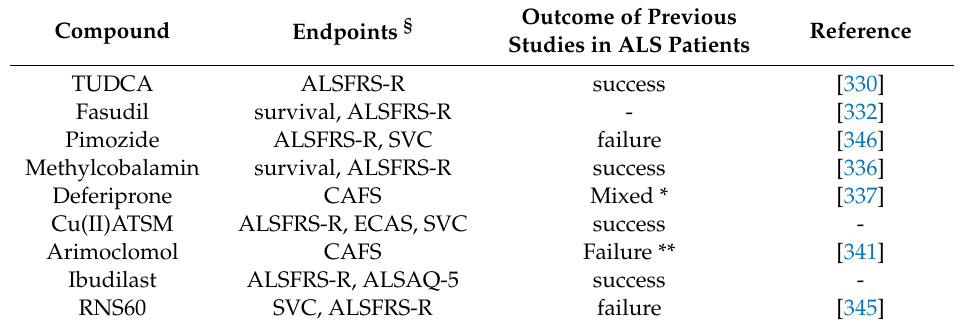
Table 3. Currently tested compounds and compounds used in studies that are recruiting